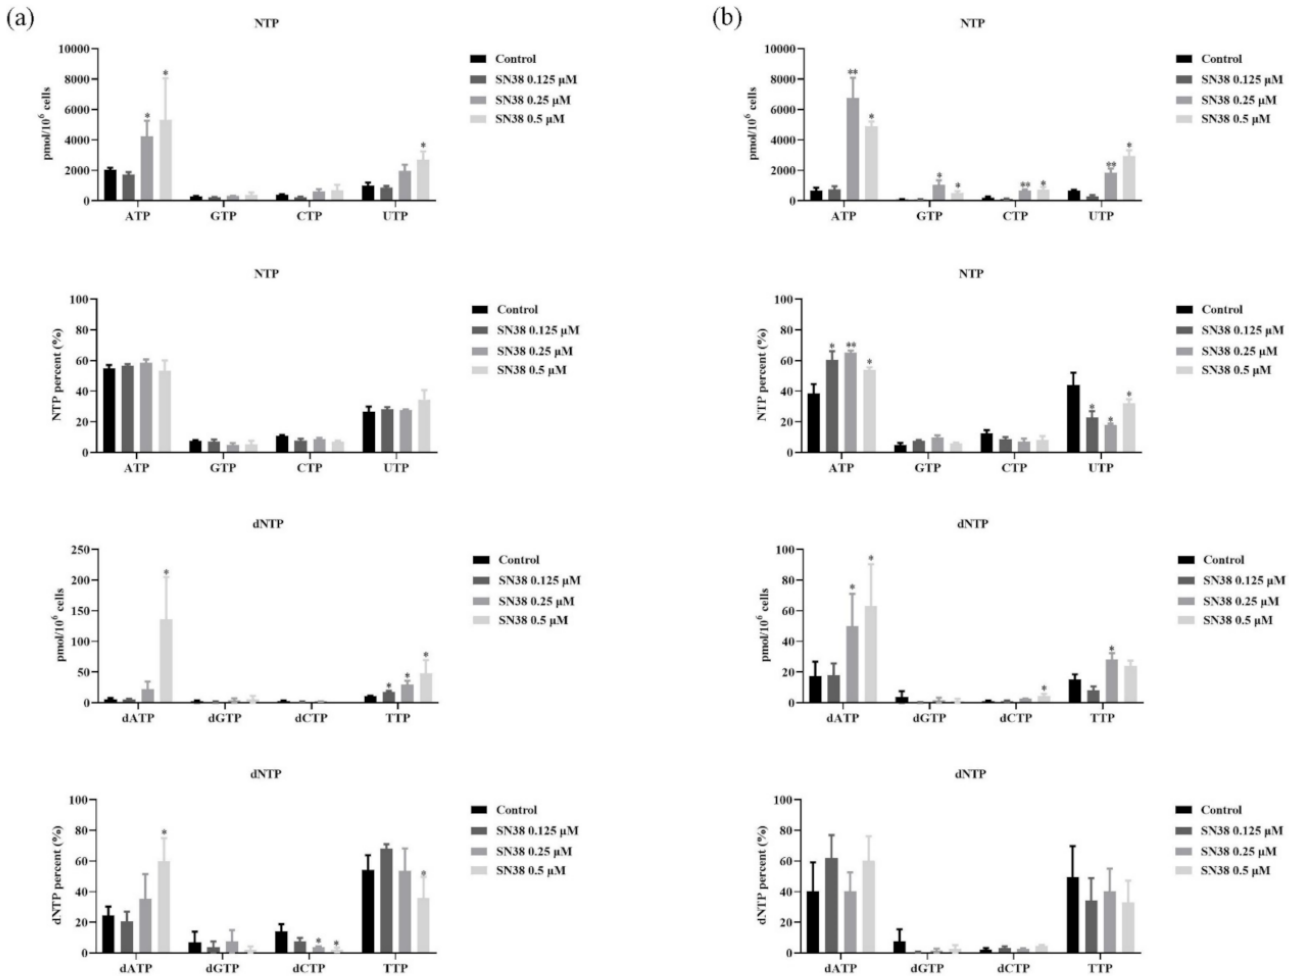
Figure 3. NTPs, %NTPs, dNTPs, and %dNTPs in cells after 24 h ( a ) and 48 h ( b ) of exposure to SN38. Note: * p < 0.05, ** p < 0.01, compared with control